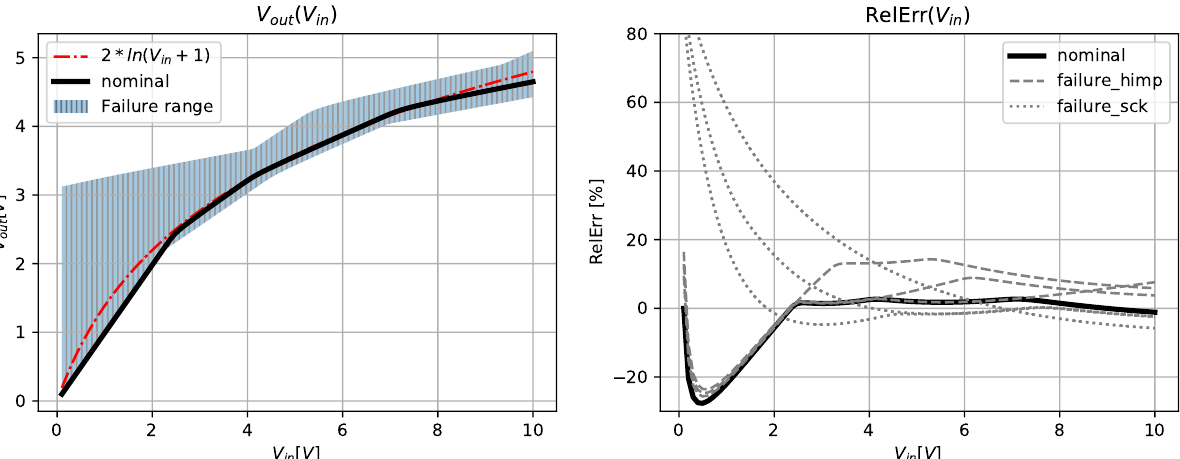
− 2ln ( V in + 1 ) ) . Stuck-open max ( V out ,2ln ( V in + 1 ))